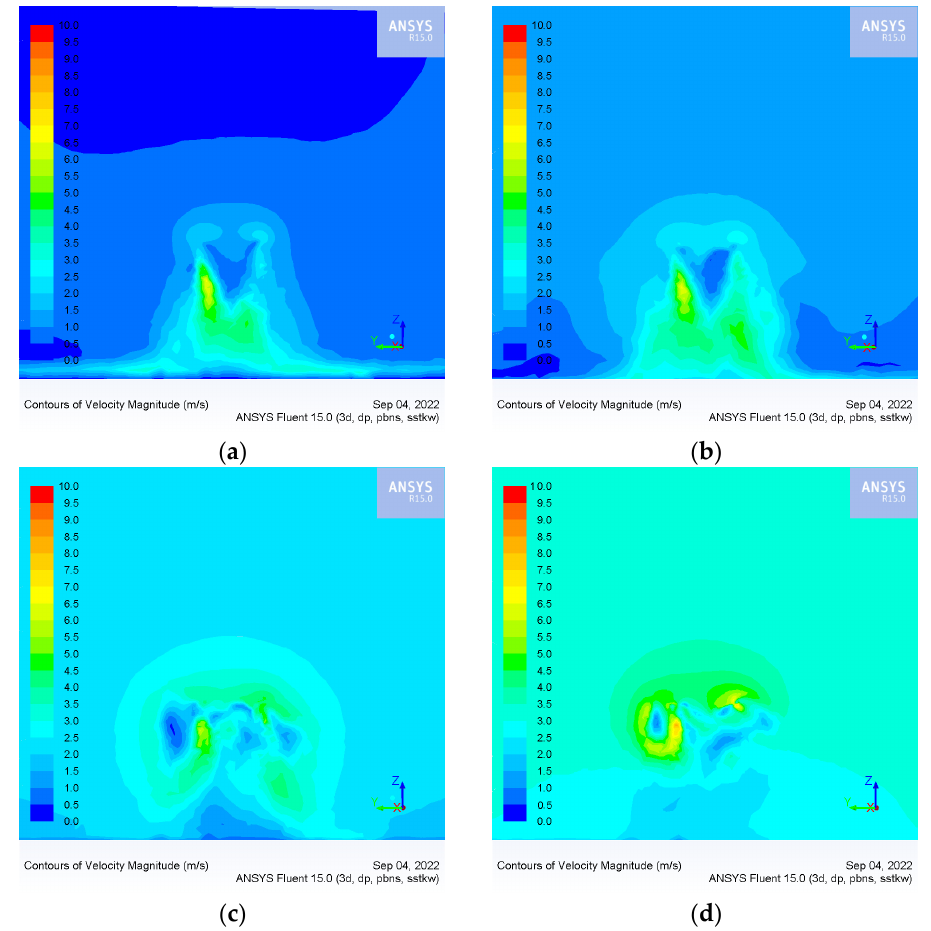
Figure 11. Wind speed field distribution of the yoz section with a flight height of 3 m, flight speed of 0 m/s, and different crosswind speeds: ( a ) crosswind speed of 0.5 m/s; ( b ) crosswind speed of 1 m/s; ( c ) crosswind speed of 2 m/s; ( d ) crosswind speed of 3 m/s.